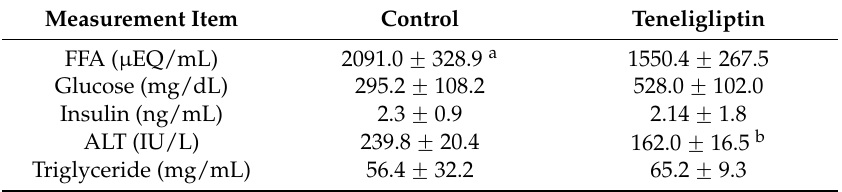
Table 2. Serum parameters in serum of the experimental mice. FFA, free fatty